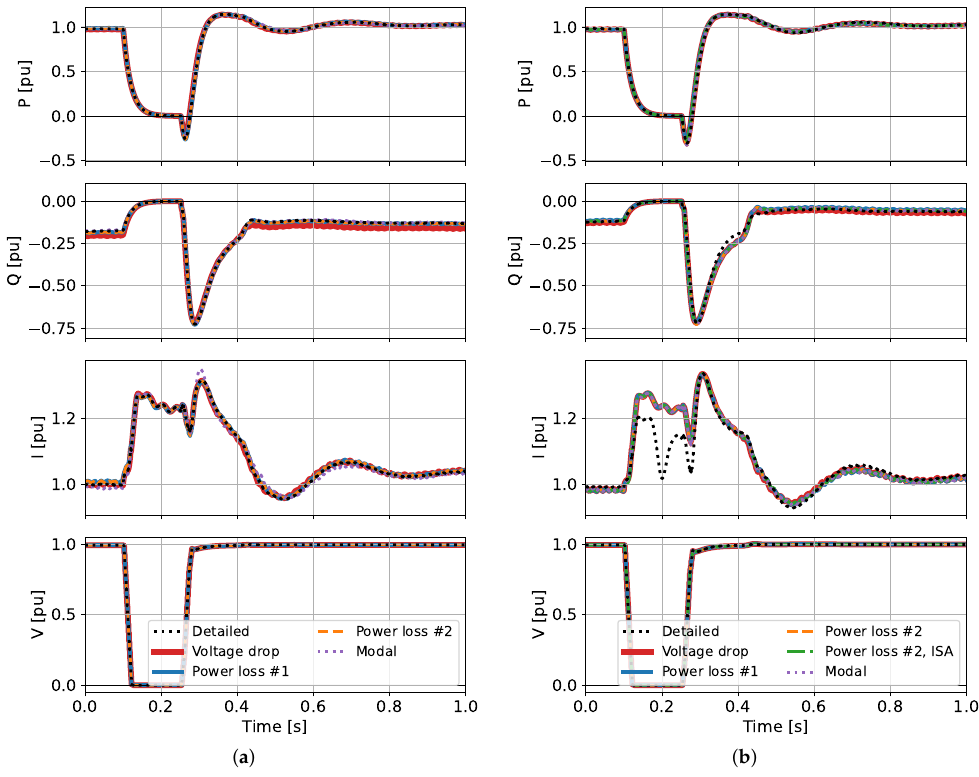
Figure 8. Selected time-domain simulations of case studies. All case studies are contained in the Appendix A. ( a ) Time-domain simulation results for case 3. ( b ) Time-domain simulation results for case